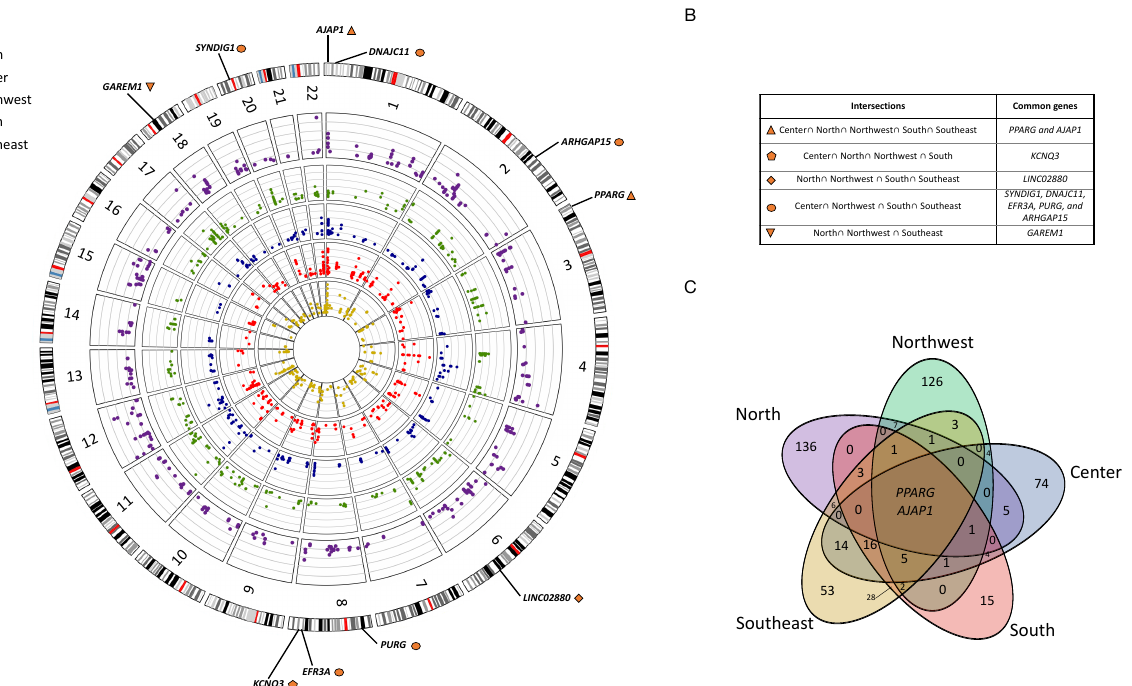
Figure 2. Significant adaptation signals in all tested regions. ( A ) SNVs under the top 1% distribution of iHS and PBS values in each region, only PBS values are plotted. ( B ) Genes symbols of selection signals shared by two or more regions. ( C ) Venn diagram showing both the number of or shared genes in all